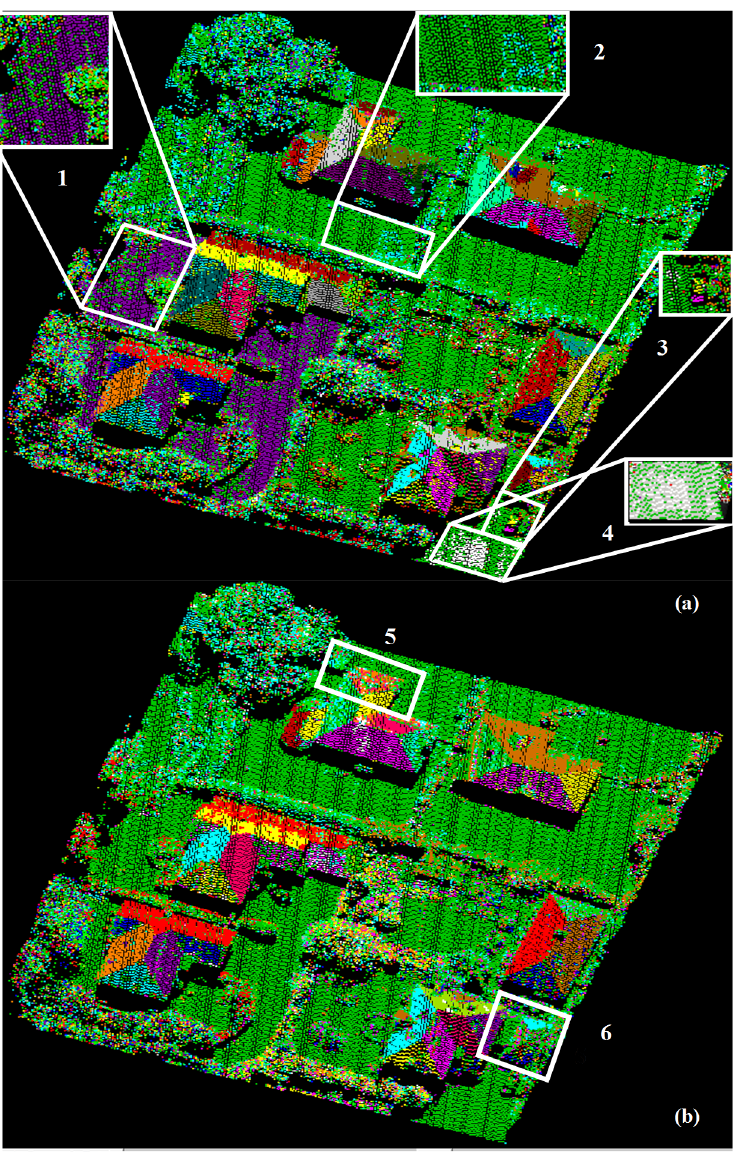
Figure 8. 3D perspective view of segmentation results for the interest area: ( a ) with FWF physical backscattering information ( b ) without FWF physical backscattering